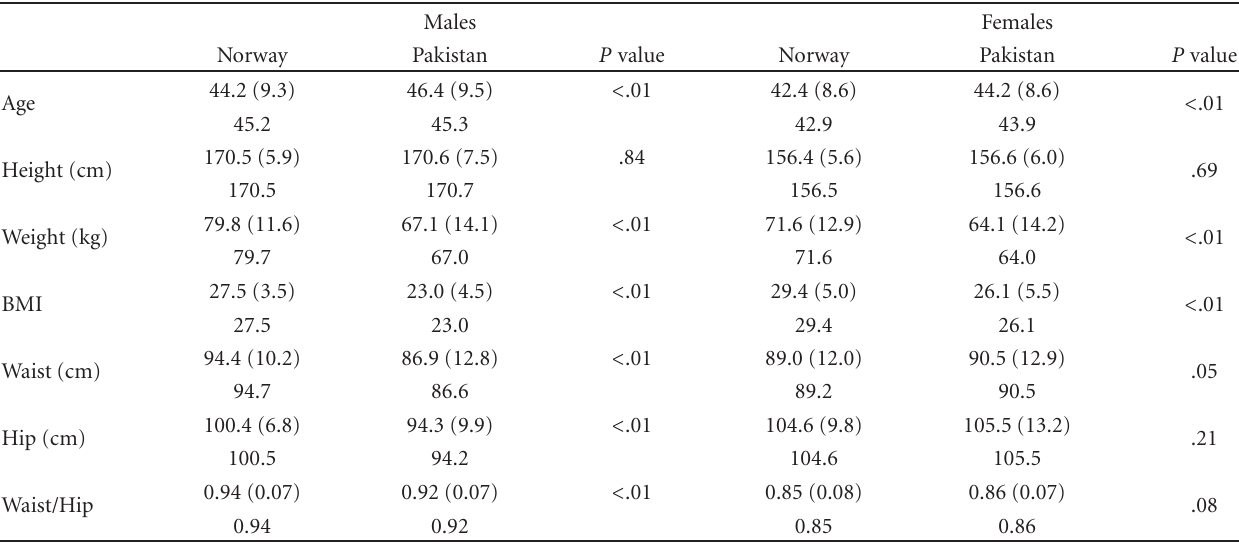
Table 1: Age and physical characteristics of the Pakistanis in Oslo and in Pakistan. Numbers are mean values with one SD in brackets. P values for di ff erence between Pakistanis and Norwegian-Pakistanis. Age adjusted values below.